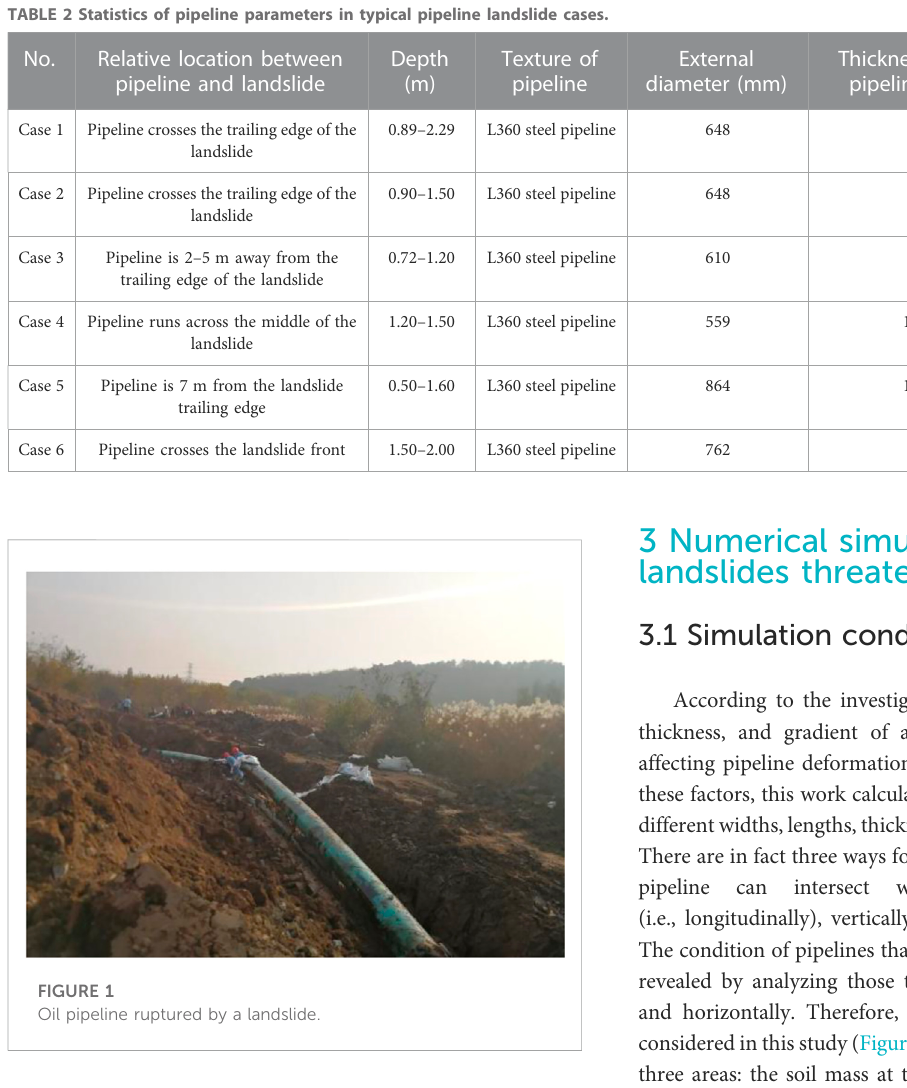
(Figure 1). The survey results show that small scale landslides are unlikely to cause a threat to the pipeline, and that the width of a landslide surface that can lead to pipeline deformation must exceed 30 m.